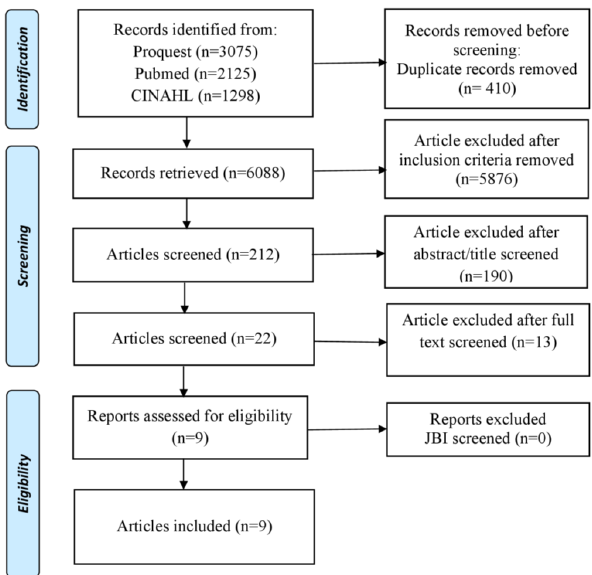
Figure 1. PRISMA Flow Diagram.